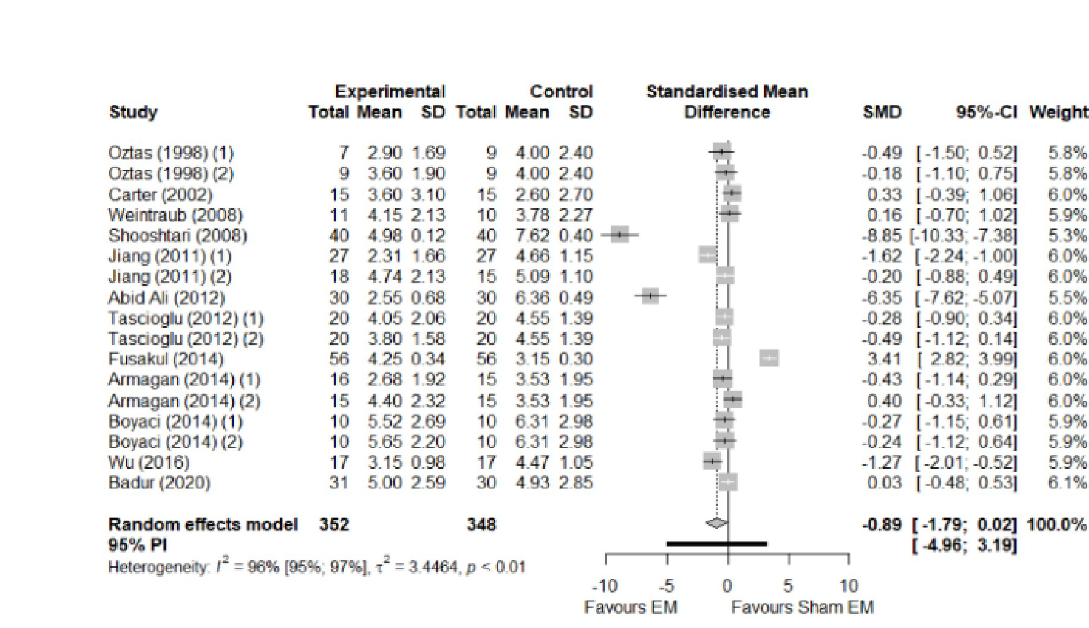
PLOS ONE | https://doi.org/10.1371/journal.pone.0248484 March 18,